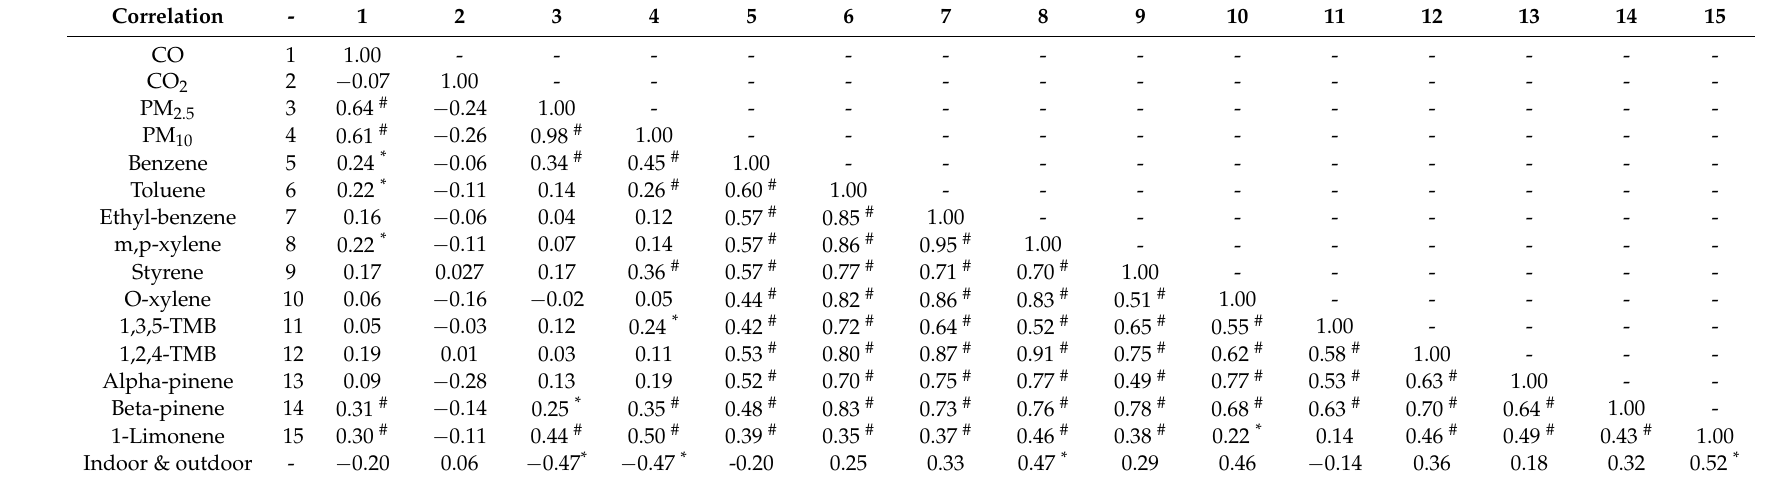
Table 5. Relative analysis of indoor compounds measured in four hot spring